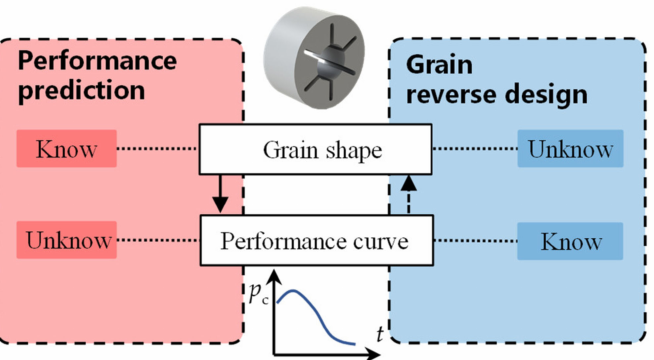
Figure 1. Relation between the performance prediction and grain reverse